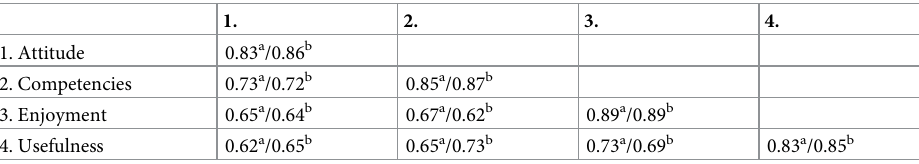
Table 7. Discriminant validity for IBL ( a ) and INT ( b ) teaching